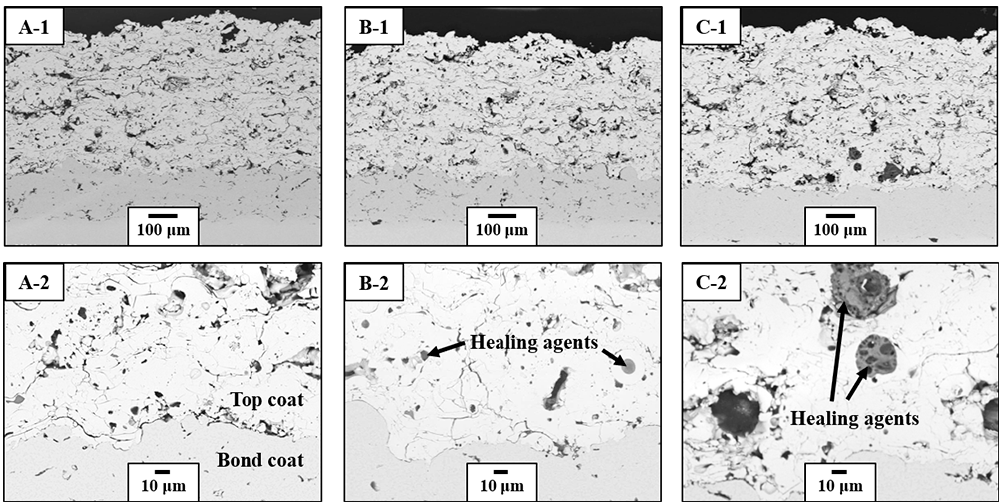
Figure 6. Cross ‐ sectional microstructures of as ‐ coated samples: ( A-1 , A-2 ) a conventional TBC (sample A), ( B-1 , B-2 ) a crack ‐ healing TBC with a buffer layer (sample B), and ( C-1 , C-2 ) a crack ‐ healing TBC with encapsulated agents (sample C). Each number indicates the magnification of (100 × ) and (500 × ), respectively.